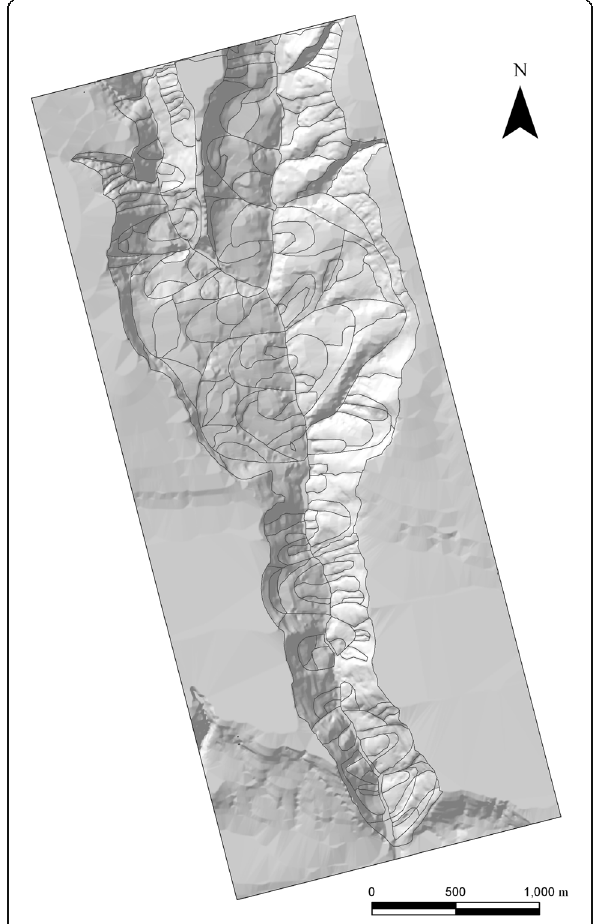
Fig. 4 Slope units from combination of DEM and reverse DEM